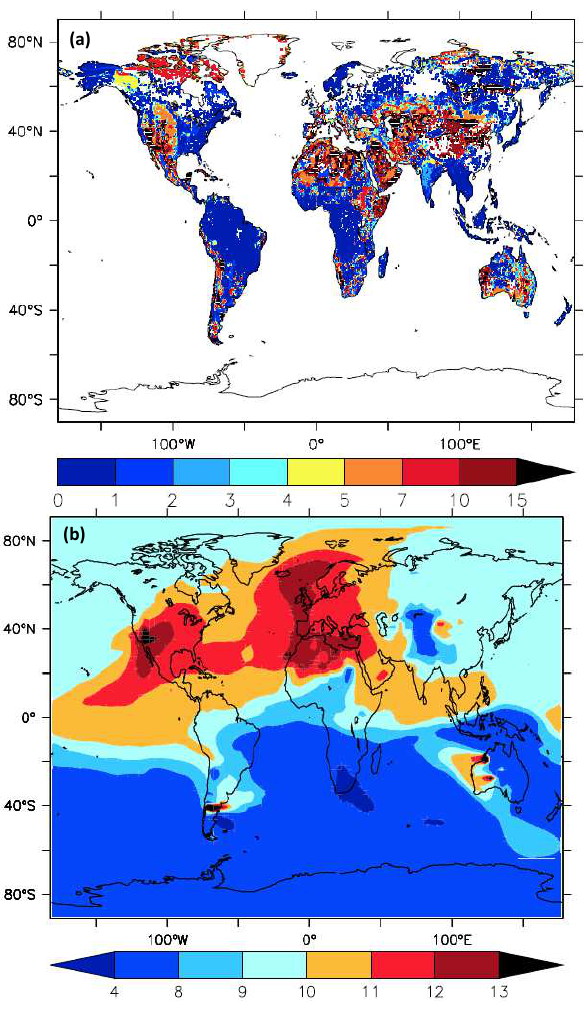
Fig. 12. Comparison of (a) soil and (b) airbone dust calcite content (mass%).